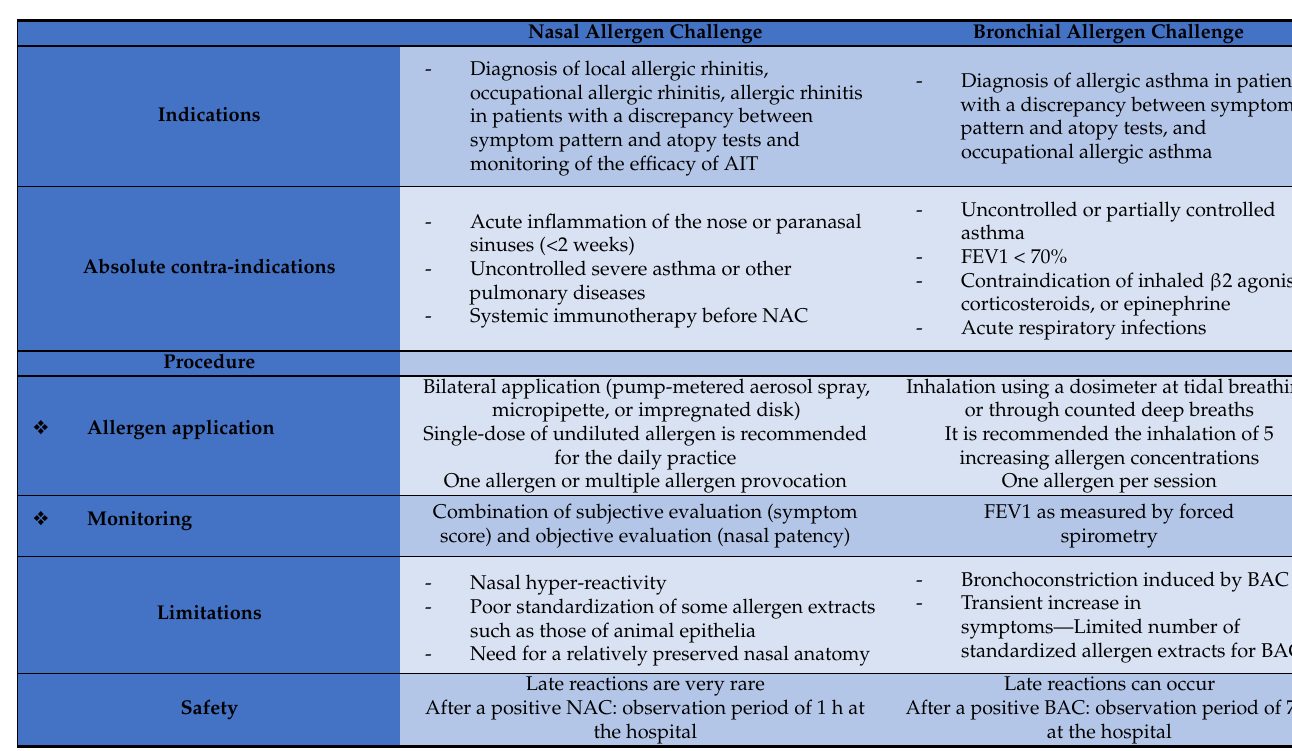
Table 1. Differences between the nasal and bronchial allergen challenges. FEV1: forced expiratory volume in the 1st second; PNIF: peak nasal inspiratory